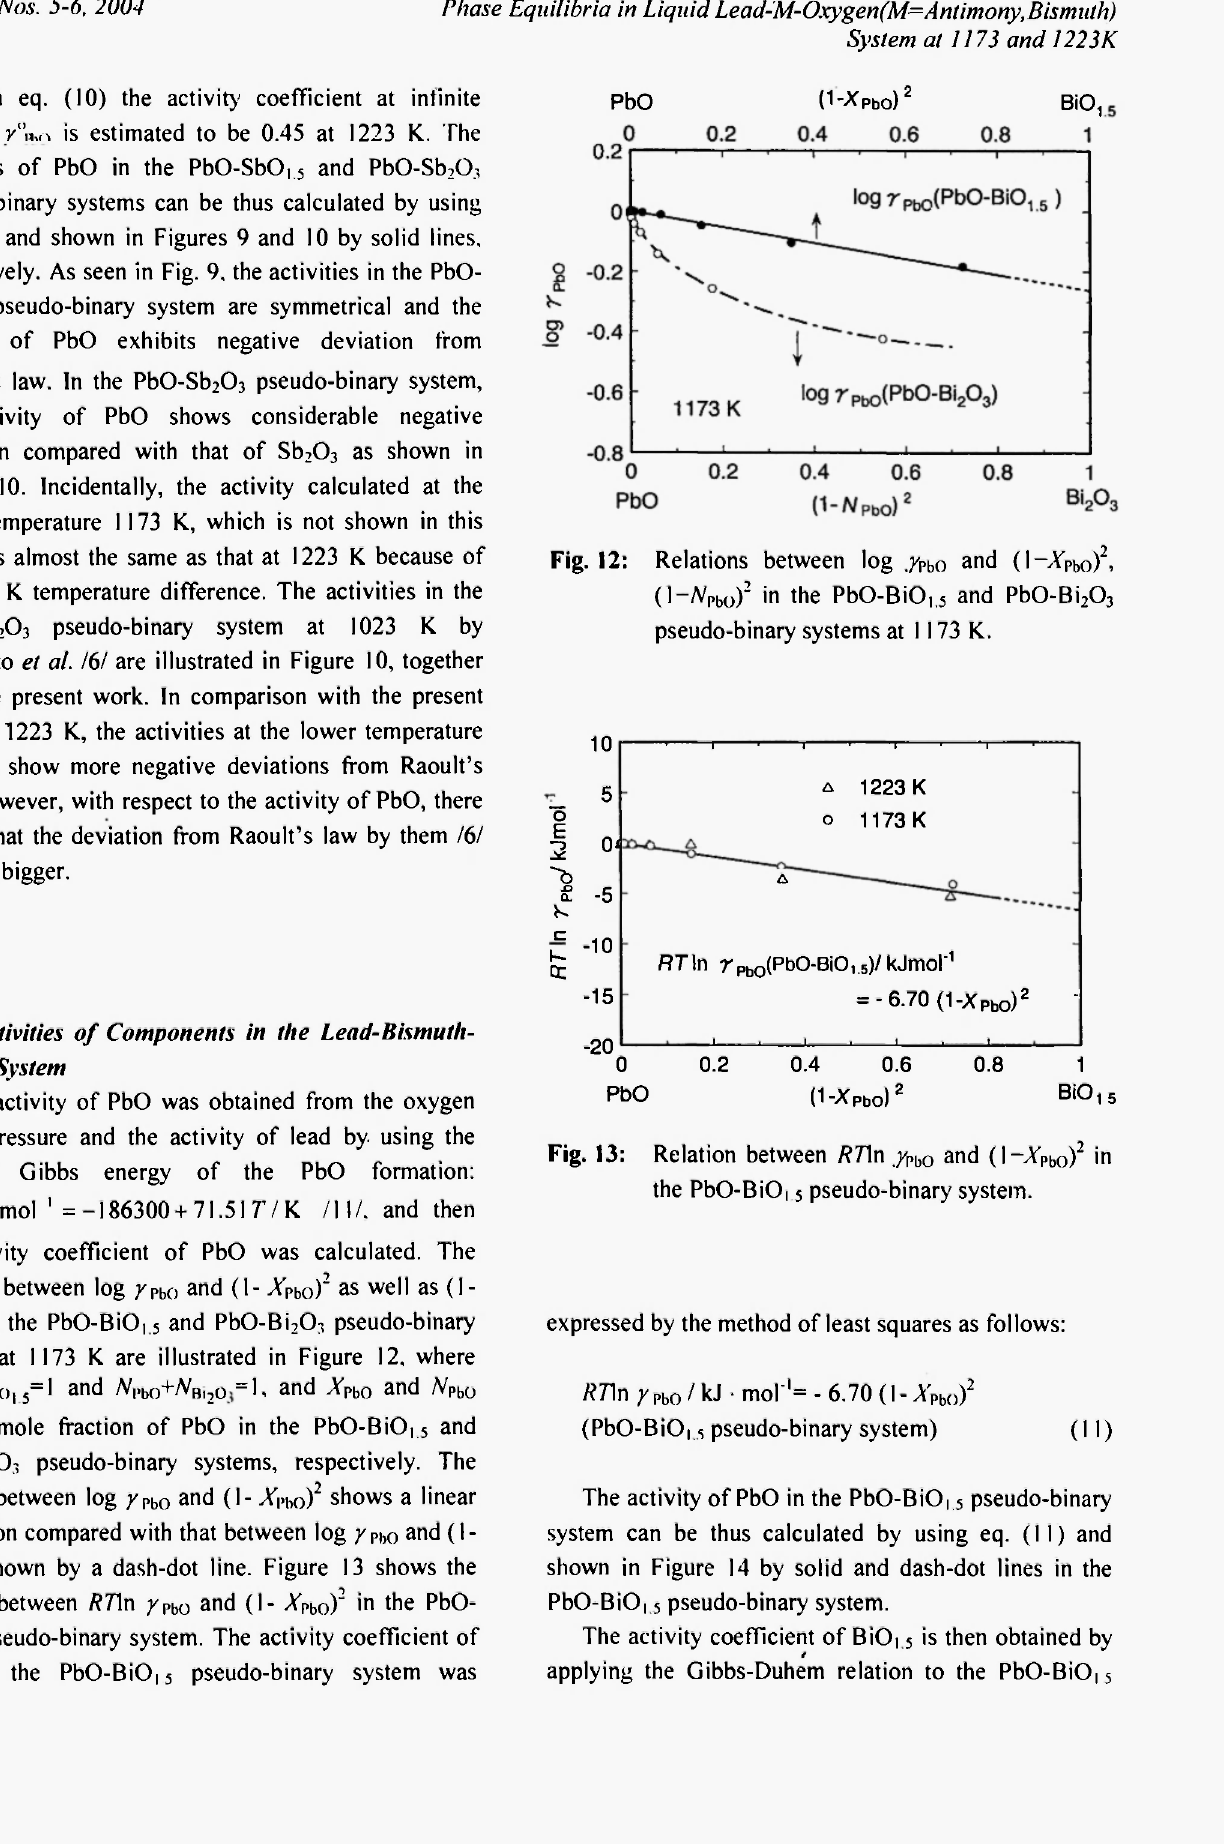
Fig. 12: Relations between log / Pb0 and (l-,Y Pb0 ) 2 , (1 -A'pbo) 2 in the PbO-BiO L5 and Pb0-Bi 2 0 3 pseudo-binary systems at 1173 K.